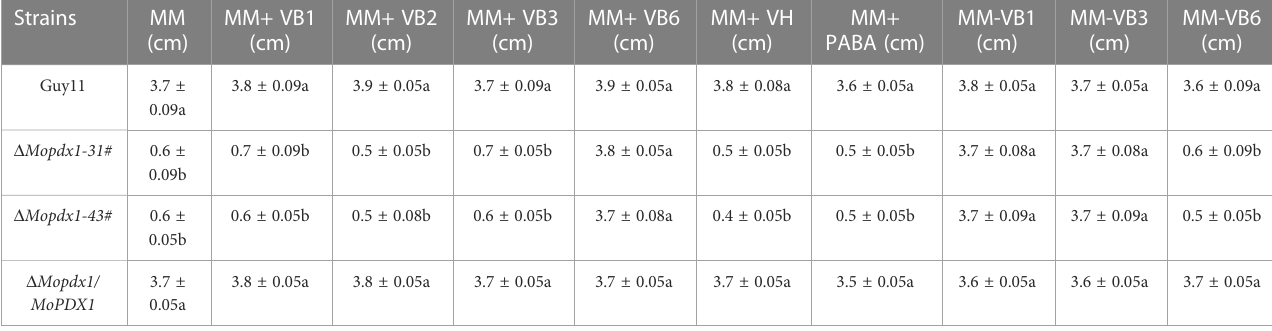
± SD was calculated from three repeated experiments and lowercase indicates statistically signi fi cant differences (LSD and Student-Newman-Keuls test, p<0.05).